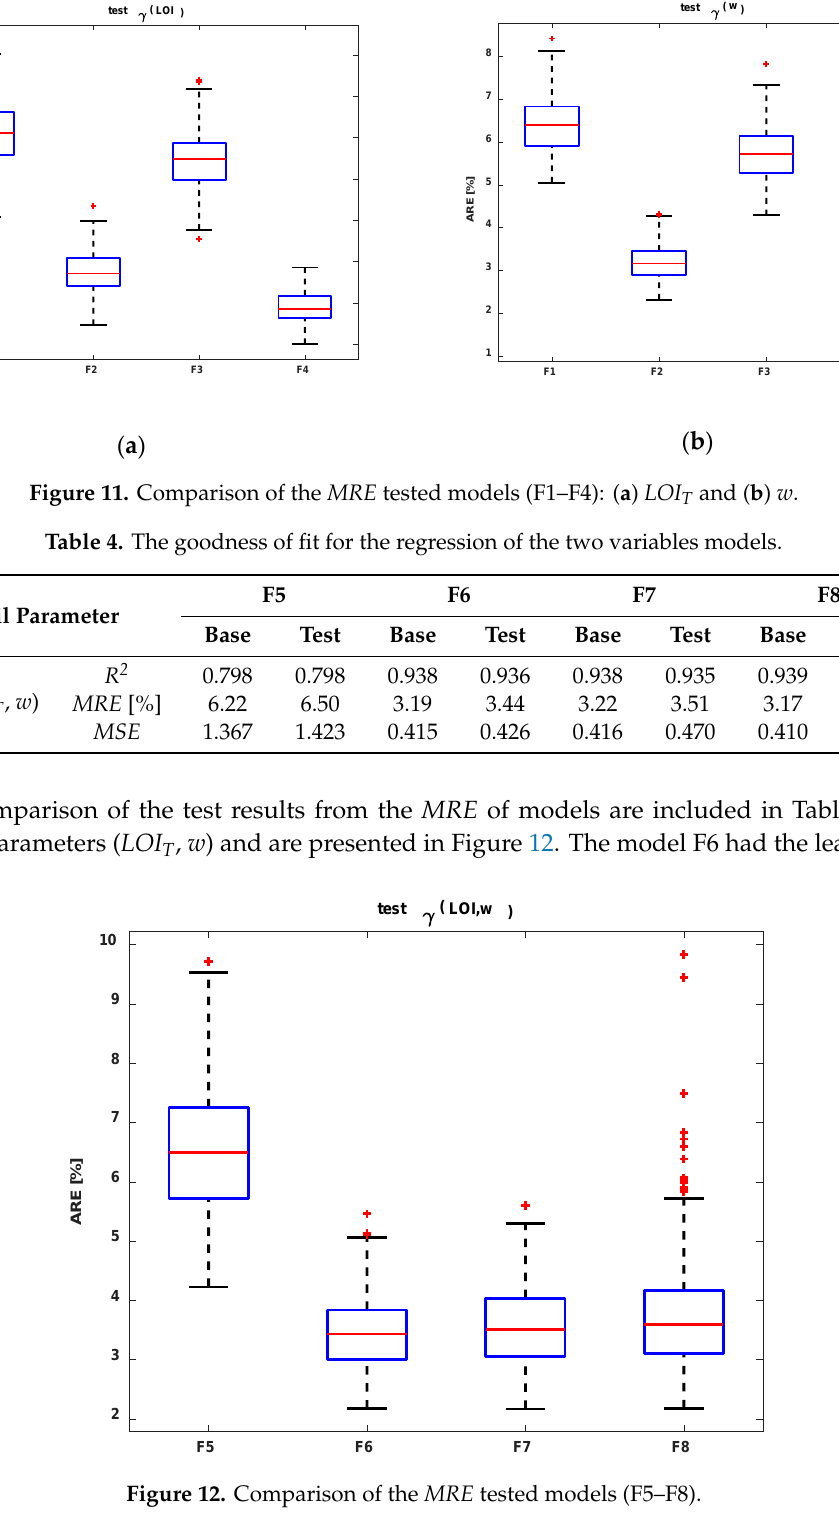
Figure 11. Comparison of the MRE tested models (F1–F4): ( a ) LOI T and ( b ) w .